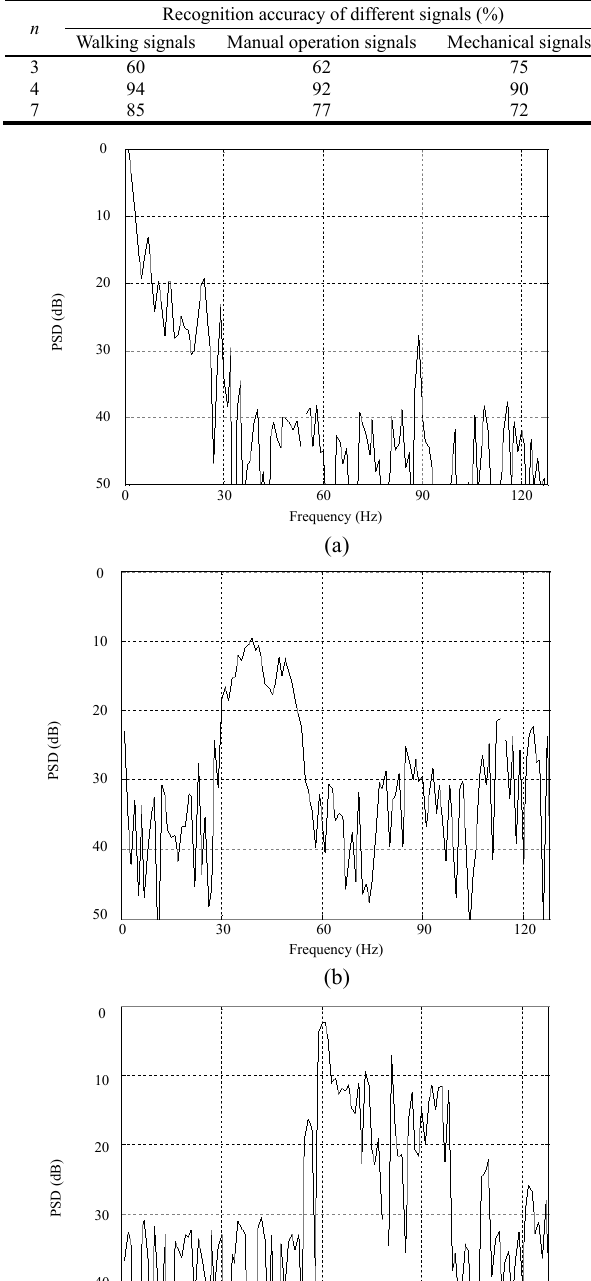
Table 1 Recognition accuracy of events at different n.